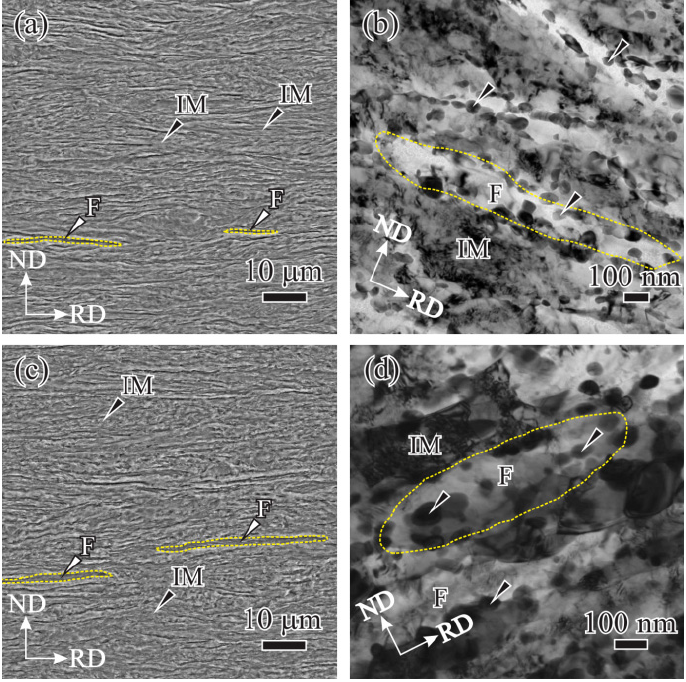
Figure 2. SEM and corresponding TEM images of quenched microstructure after inter-critical holding at 755 °C for ( a , b ) 90 s and ( c , d ) 120 s.